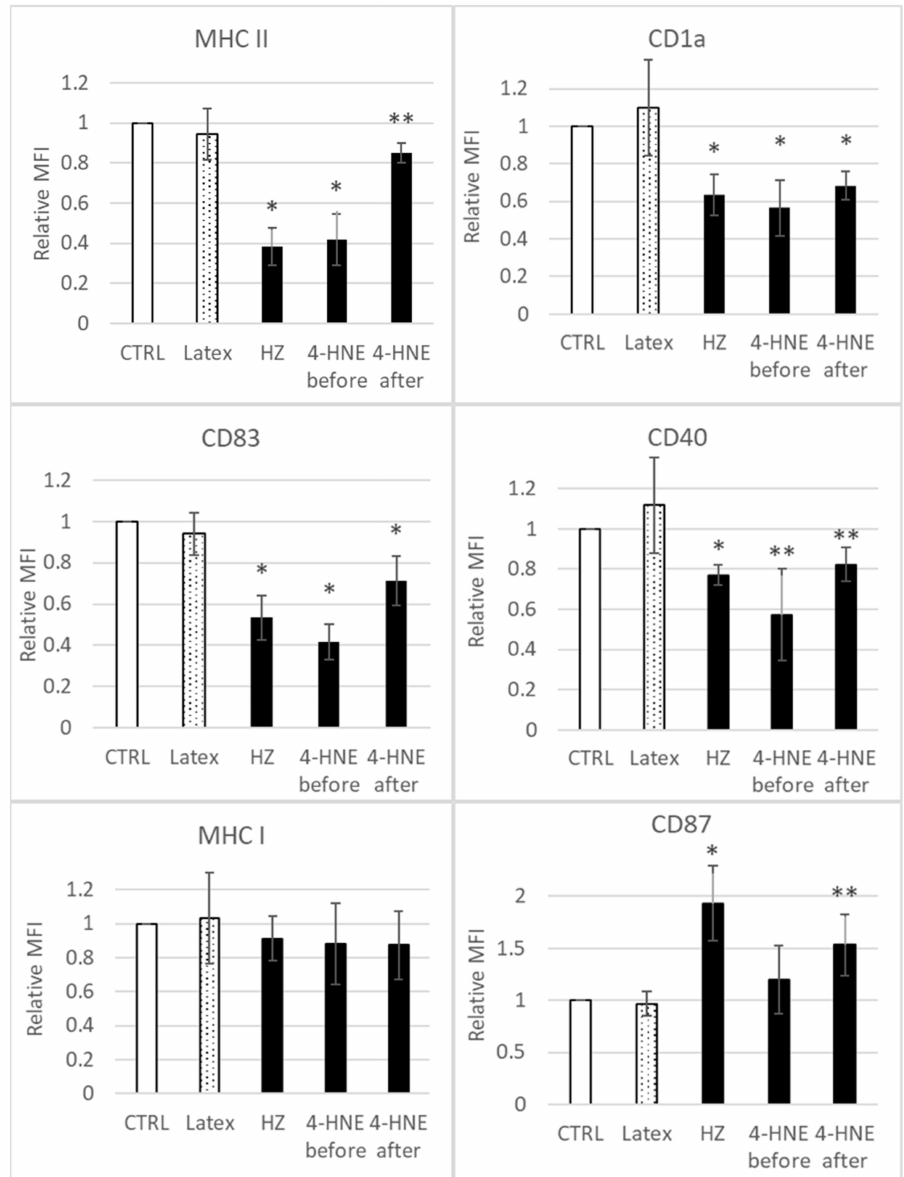
Figure 2. HZ phagocytosis and 4-HNE treatment affected the expression of DC markers. Surface antigen expression in monocyte-derived DC, which had phagocytosed neutral latex beads (Latex), hemozoin (HZ) or were repetitively treated with 1 µ M 4-HNE during differentiation either before (4-HNE before) or after (4-HNE after) GM-CSF/IL-4 stimulation, which was quantified by flow cytometry after immunostaining at day 7 of differentiation and related to MFI in untreated control DC (CTRL). Mean values ± SE. Significance: *, p < 0.01; **, p < 0.05, n = 3